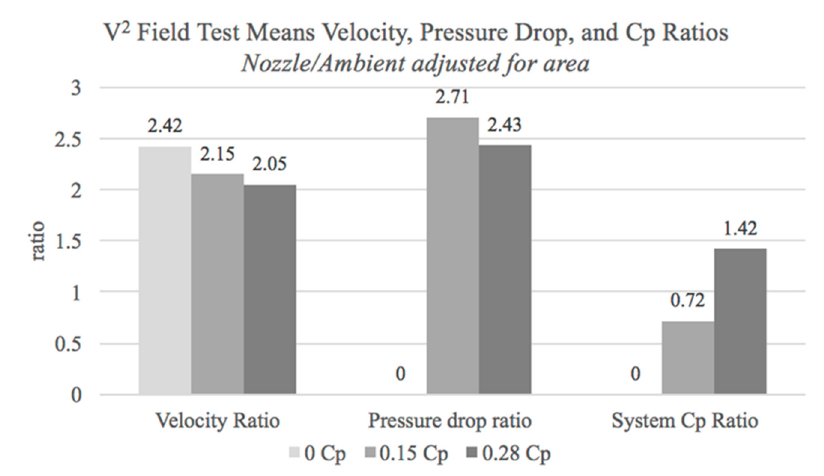
Figure A4. Mean Test data ratio to freestream turbine variables at 0, 0.15, and 0.28 rotor C P .